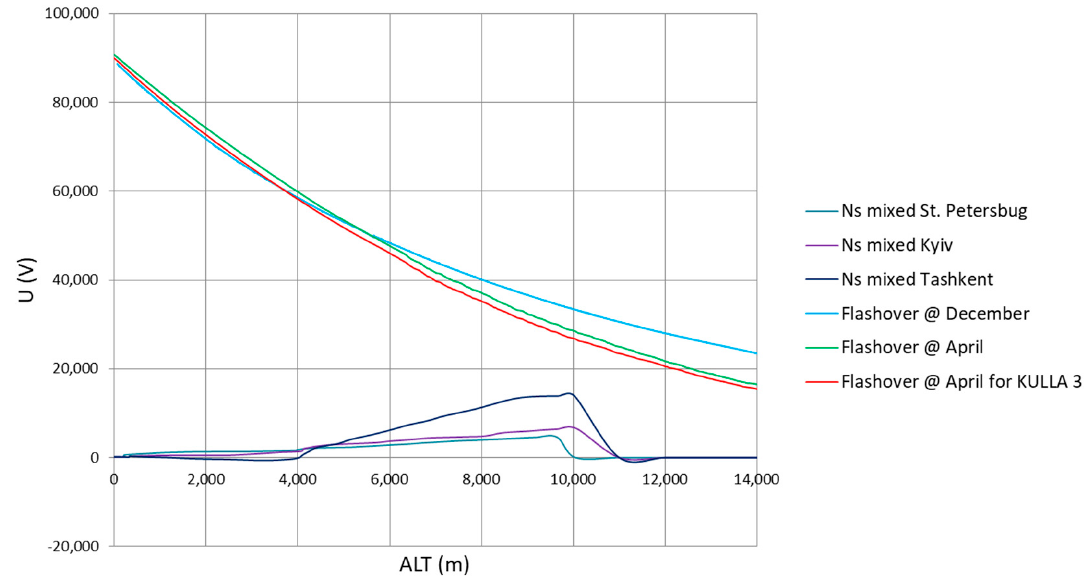
Figure 5. The flashover and induced voltage through the Nimbostratus clouds on the 500 m-long fully airborne antenna during the ascent.